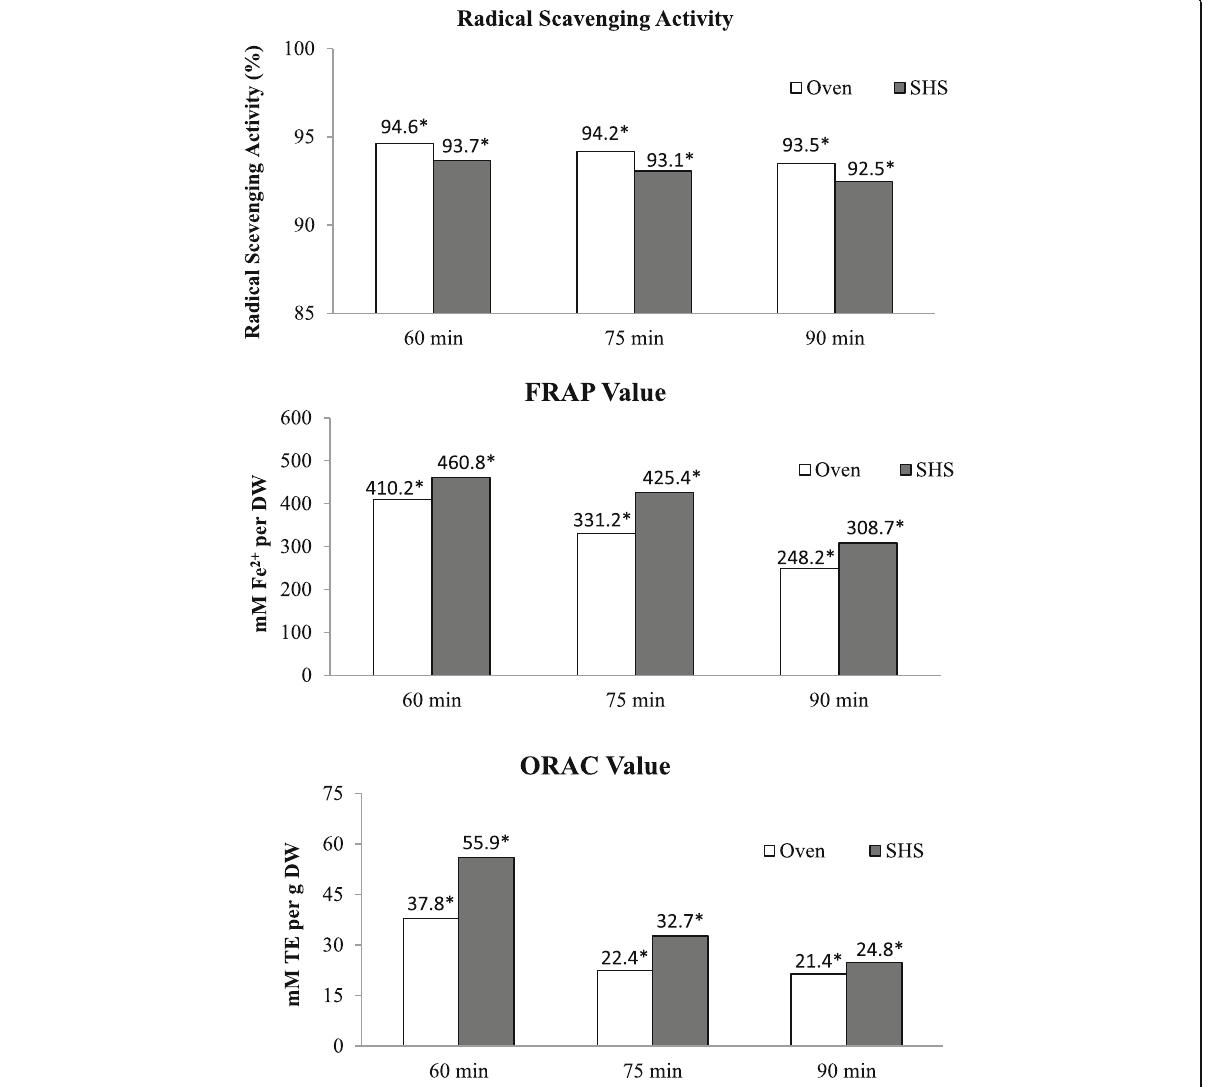
Fig. 4 Comparison of antioxidant capacity between oven dried and SHS dried tea leaves at different drying duration. (*) indicates significant differences ( p < 0.05) between values at the same time based on independent sample t-test. (SHS = Superheated